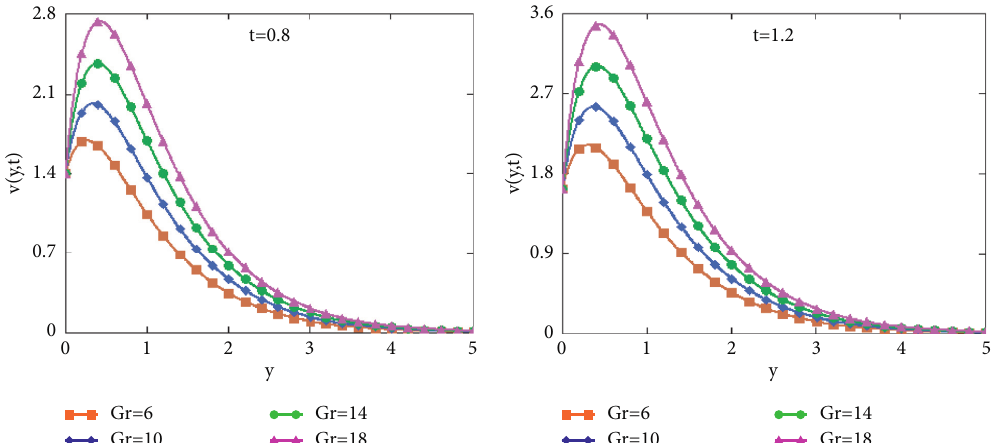
Figure 3: Velocity profile v ( y,t ) for various values of Gr at R � 1 . 4 ,Q � 0 . 4 , Gm � 6 , M � . 85 , Sc � 4 . 5 , α � β � c � 0 . 5 , B � 0 . 2 , and Pr � 4 . 0.